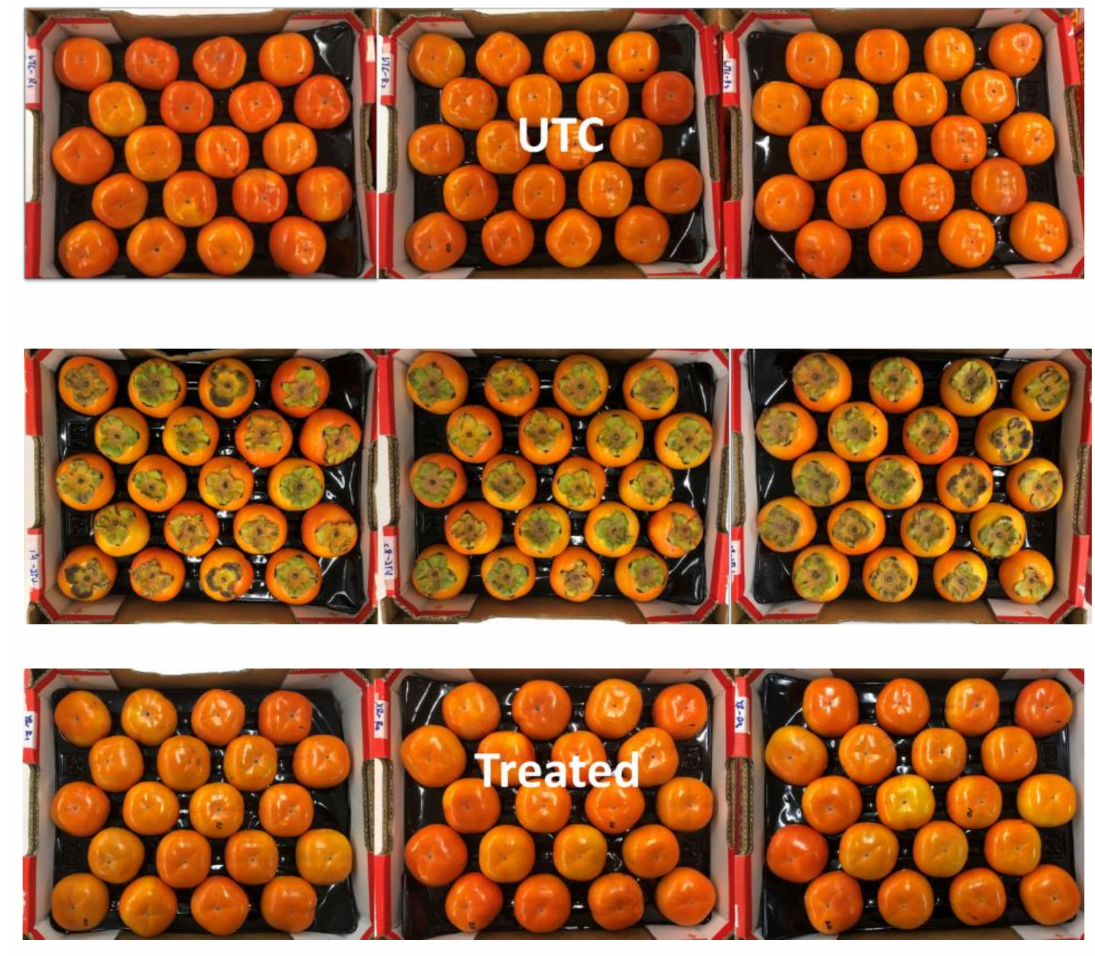
Figure 1. Skin colour parameters (a*, b*, hue angle and L*) of treated and untreated control (UTC) ‘Jiro’ persimmon fruit during storage at 15 ◦ C for up to three weeks. Data are means ( n = 3) and standard deviations around the mean are shown in error bars. Values with the same letter within each assessment time are not significantly di ff erent using the LSD test at p < 0.05.